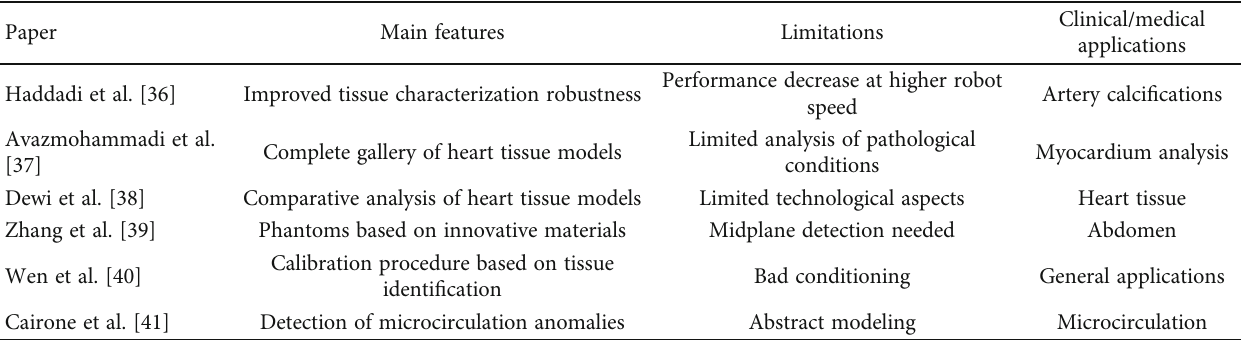
Table 3: Comparison of mechanical characterization of methods for